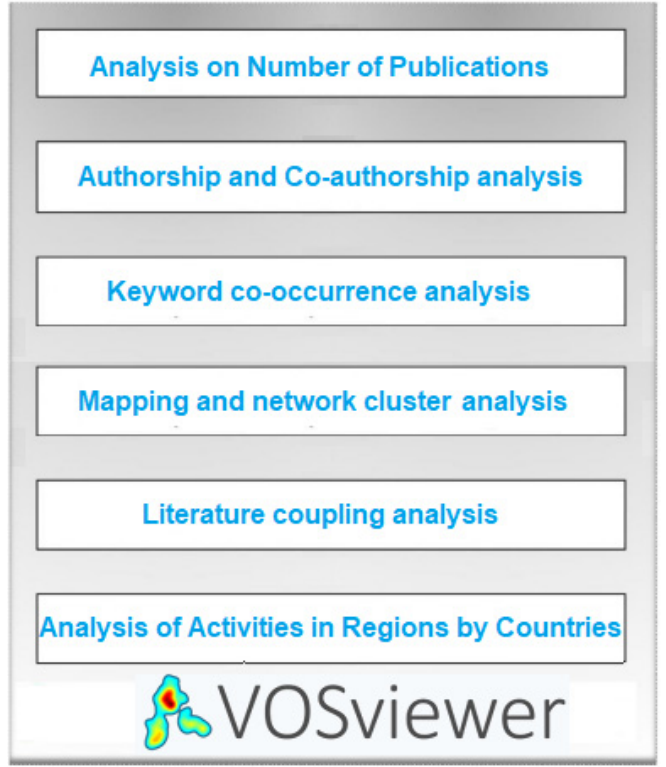
Figure 5. Different analyses conducted using VOSviewer.